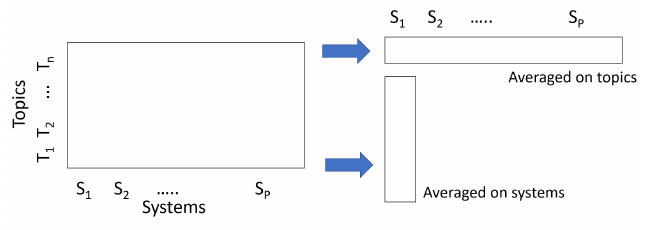
Figure 5. Aggregated values can be considered, either on the queries or